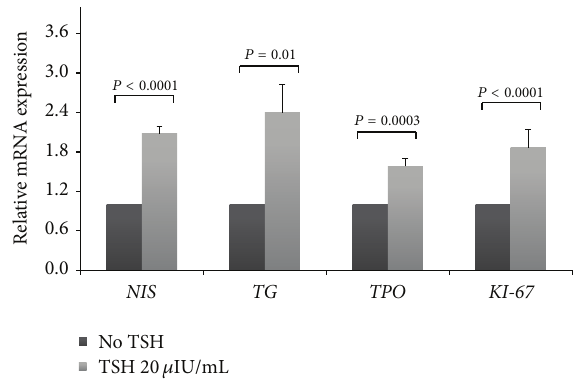
Figure 3: Progesterone (P) increased mean mRNA expression of human normal thyroid follicular cells genes in primary culture. The sodium-iodide symporter NIS gene was evaluated after 4h, and the thyroglobulin TG , thyroperoxidase TPO , and KI-67 genes were evaluated after 48 h. These effects were abolished by mifepristone (M). Data were obtained by RT-qPCR and normalized with 𝛽 -actin gene expression and are shown as the mean ratio of treatment/TSH ± standard deviation, considering TSH = 1. The experiments were performed in duplicate and repeated in three independent cultures for 𝑁𝐼𝑆 and four independent cultures for TG , TPO , and KI-67